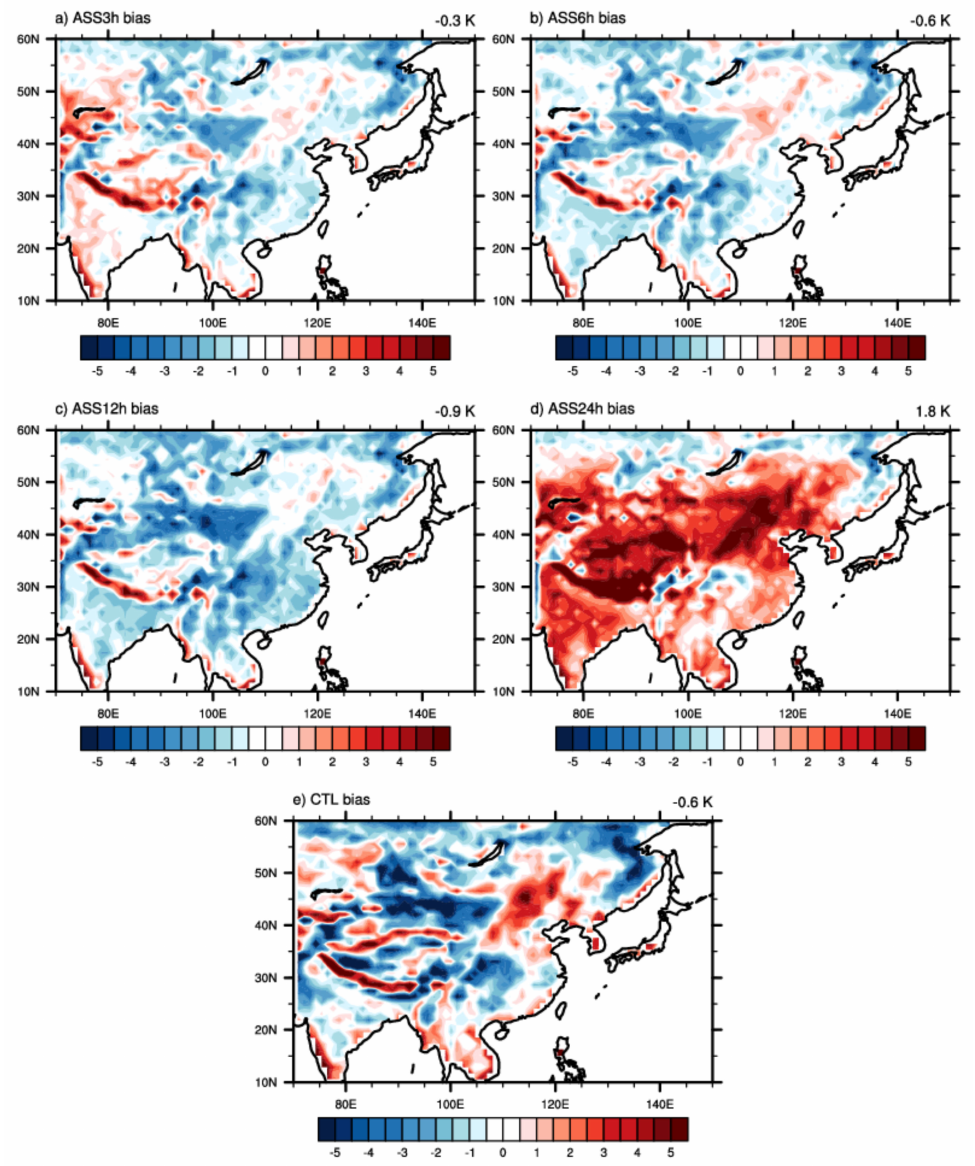
Figure 5. Same as in the Figure 2 but for the nighttime